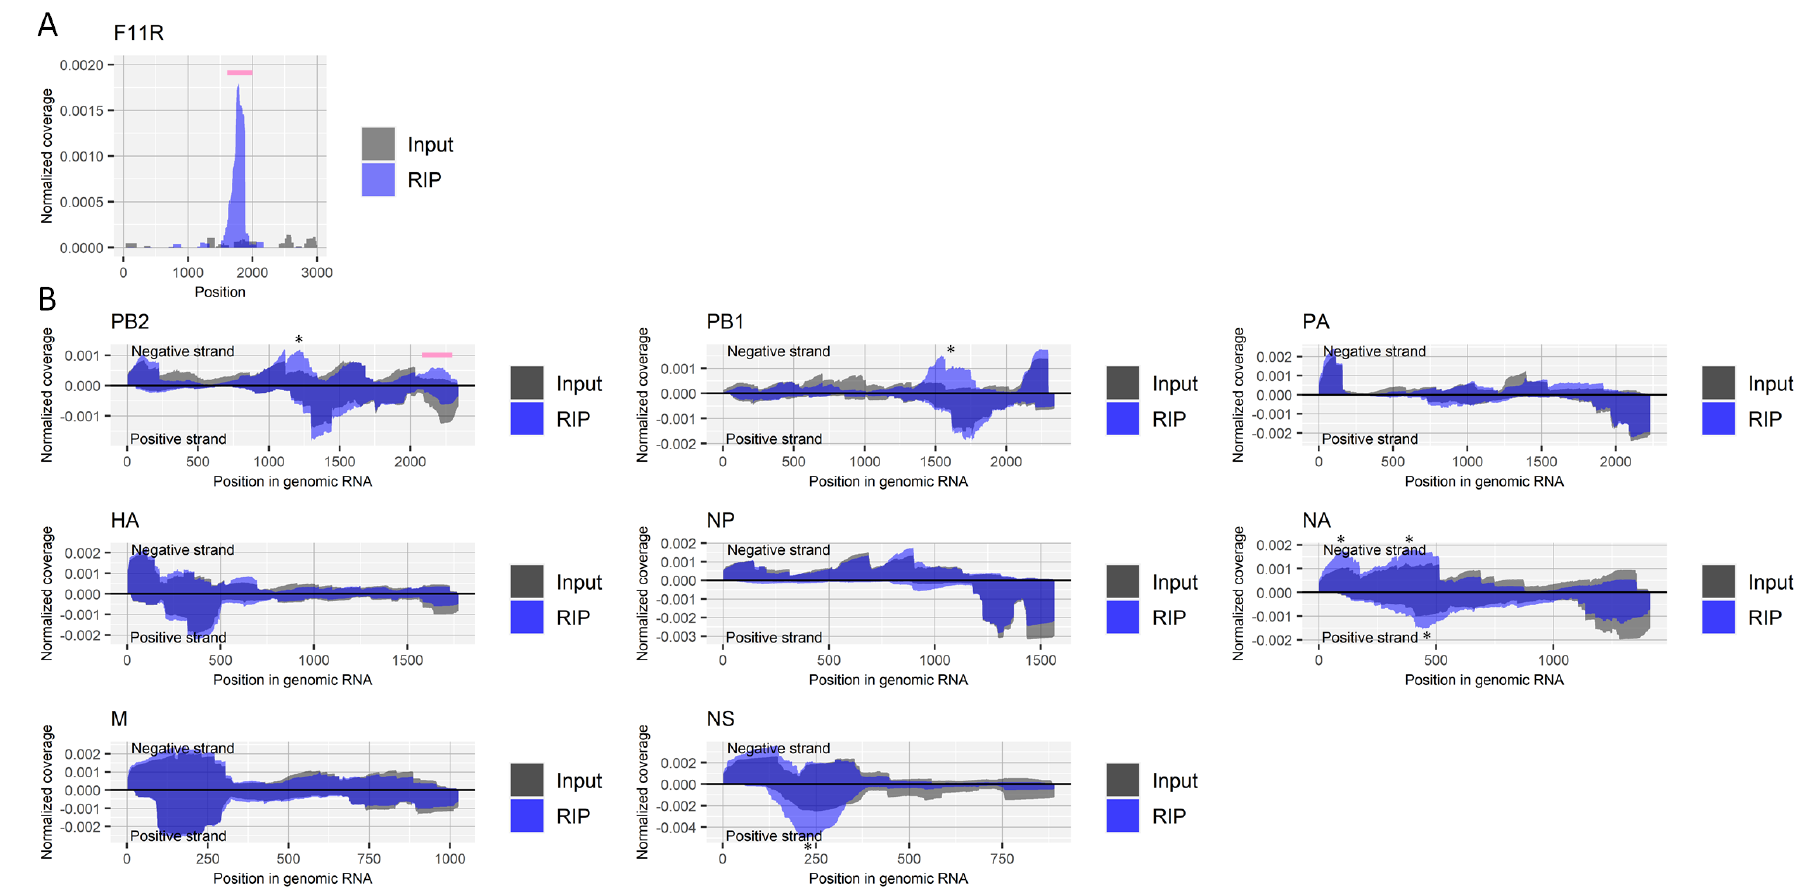
Figure 1. Detection of regions that include inosine in RNA derived from influenza A virus. ( A ) Read coverage of deep-sequencing in the host’s F11R gene normalized by the number of read counts mapped to the transcript for RIP and input samples. A pink bar indicates a known region with inosine. ( B ) Read coverage of deep-sequencing in negative-strand RNA (positive values) and positive-strand RNA (negative values) of each viral segment normalized by the number of read counts mapped to each transcript for RIP and input samples. A pink bar indicates an enriched region that possibly contains inosine. The criteria to identify RIP-enriched regions were at least two-fold enrichment, inosine antibody-specific enrichment, and enrichment in two biological duplicates. * non-specifically enriched region that was also observed in other experiments. Results of the biological replicate experiment are available in Supplementary Figure S1.